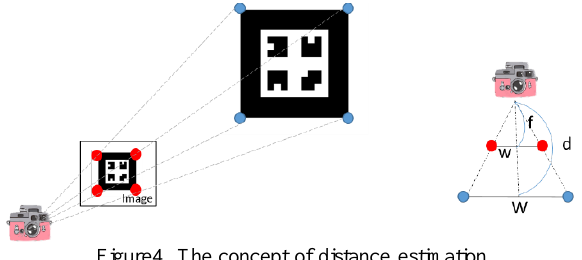
Figure 2. The self-designed marker